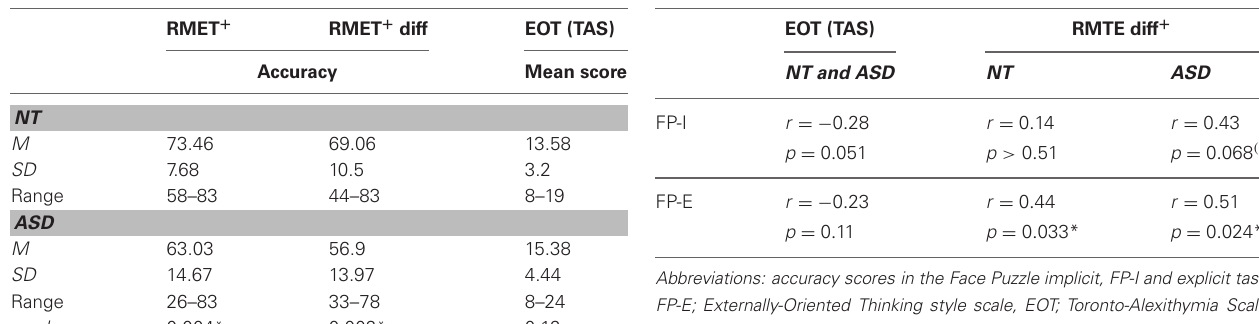
lower : Face Puzzle implicit task, left : ADOS, Right : ASDI. Abbreviations: Autism Diagnostic Observation Schedule, ADOS; Asperger Syndrome and High Functioning Autism Diagnostic Interview, ASDI.